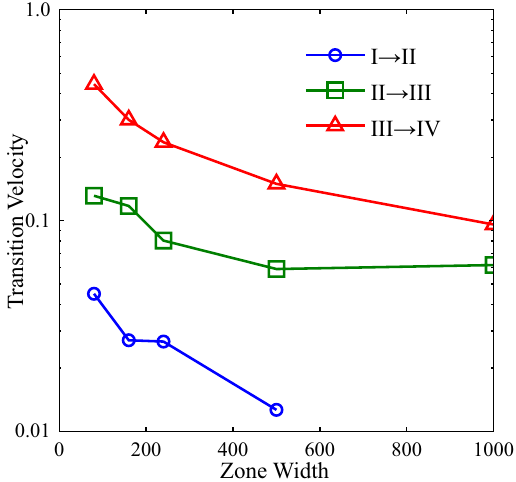
Figure 8. Transition velocities for Regions I-II, II-III, and III-IV as a function of the zone width, w zone . The full data and a description of the approach to calculate these transitions is provided in the Supplemental